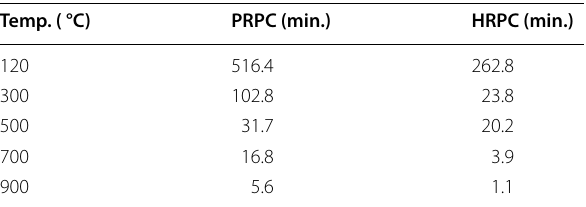
Table 6 Predicted time for STC of RPC equivalent to 1-year ambient temperature creep of RPC.